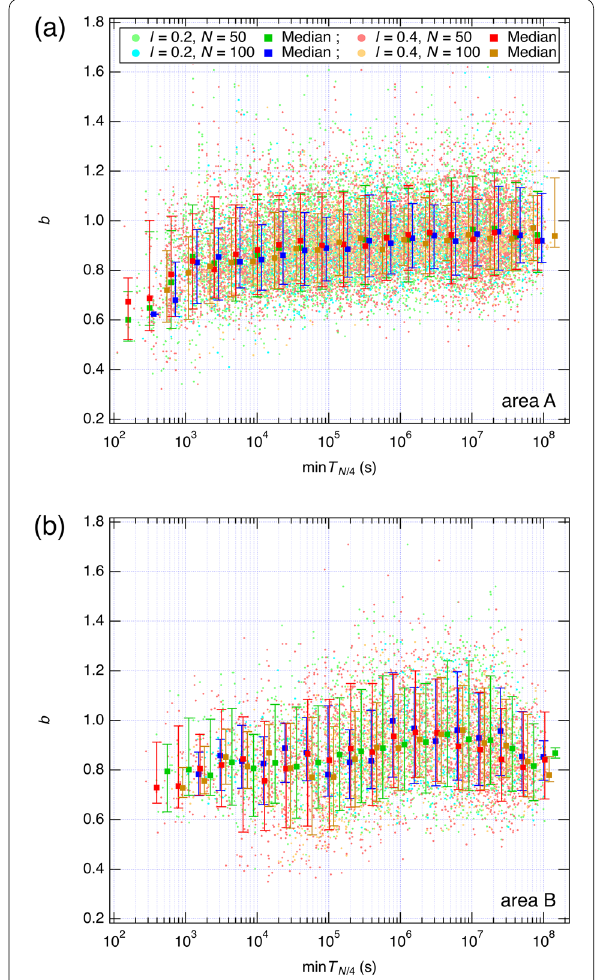
Fig. 14 Relationship between b and min T N / 4 in a region with a typical b -value PDD. Squares represent the median values in the range of 0.5 to 2 times the horizontal axis values, and the vertical bars represent the 90th and 10th percentiles. a Area A; b area